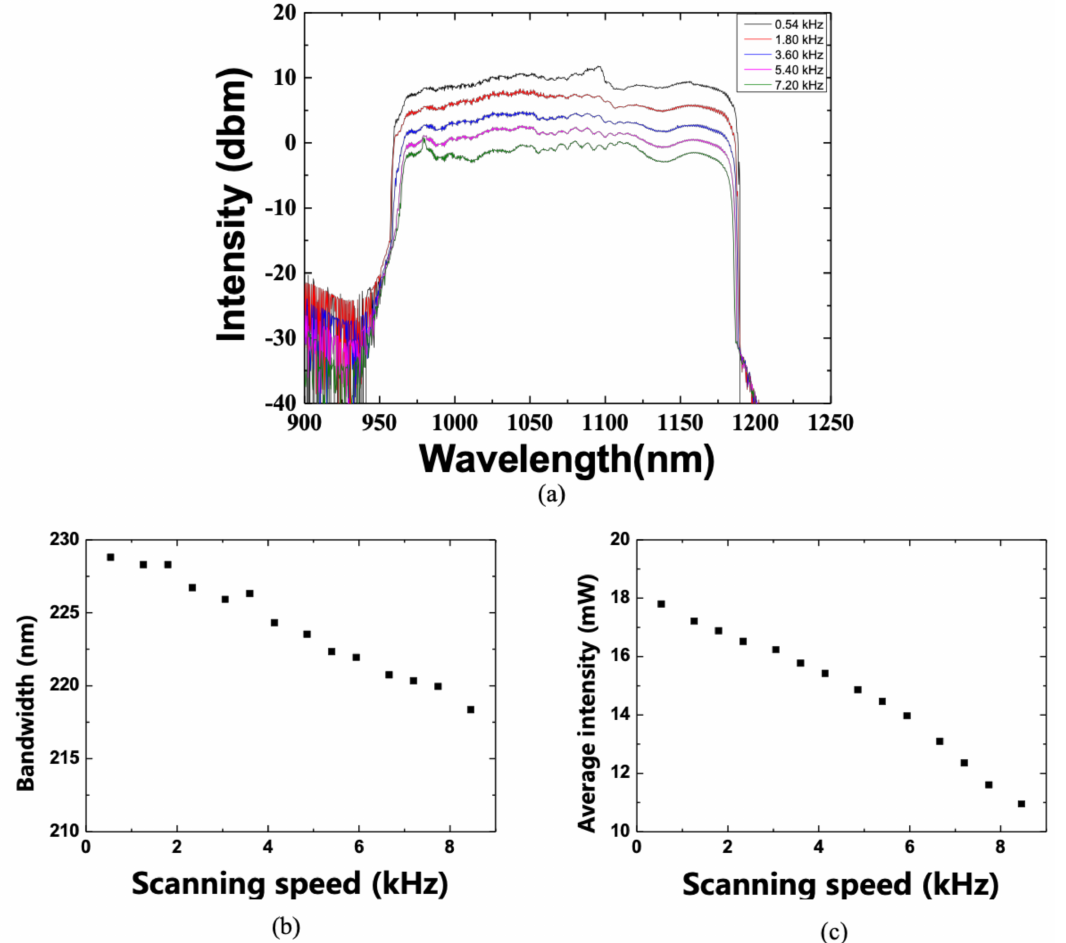
Figure 5. ( a ) Optical spectra, ( b ) 10-dB bandwidth, and ( c ) average optical power with respect to the WSL scanning